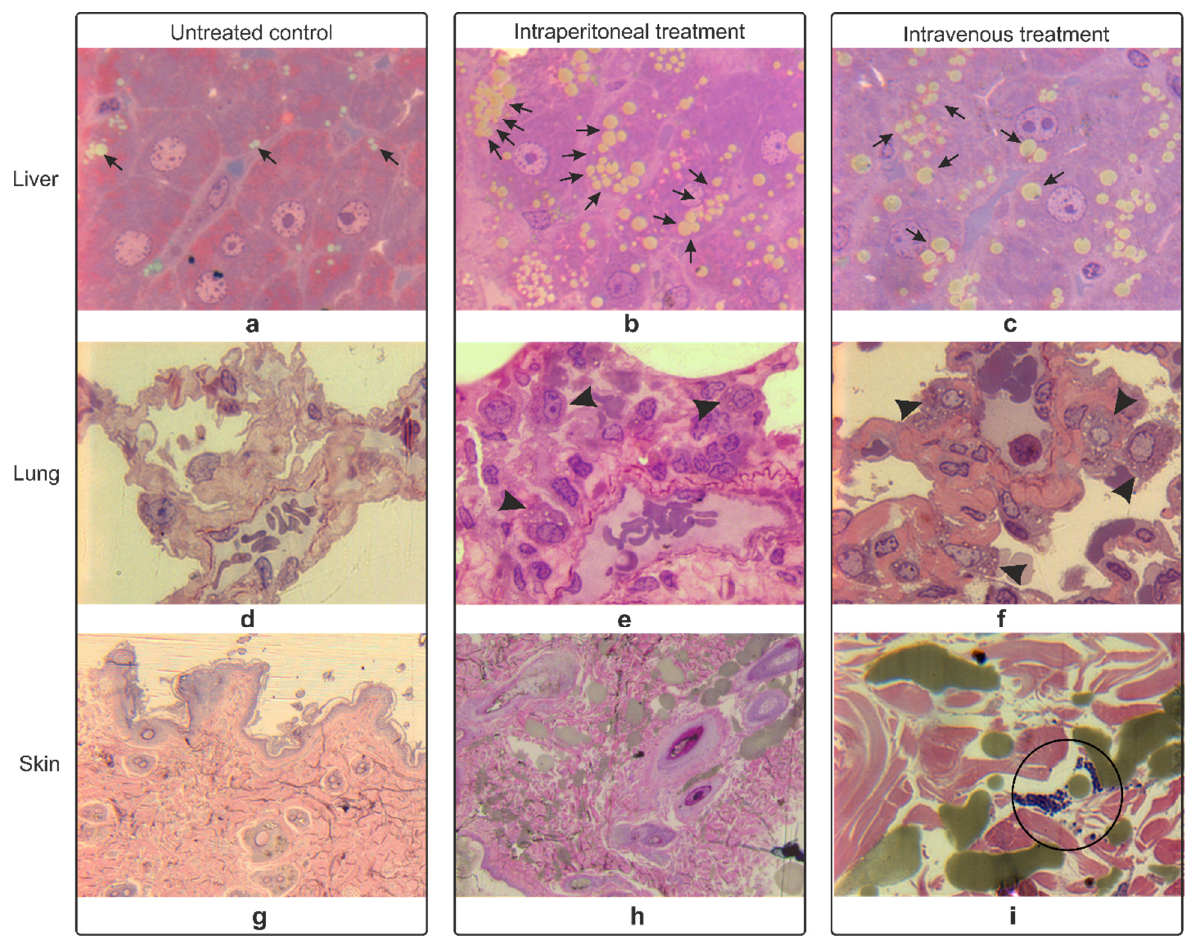
Figure 4. Semi-thin sections of the liver ( a – c ), lung ( d – f ), and skin ( g – i ) examined at 24 h post-intraperitoneal-treatment and 24 h post-intravenous-treatment and compared to the untreated controls; arrows = lipid accumulations, arrowheads = activated macrophages, circle = dense accumulations; 100× magnification.